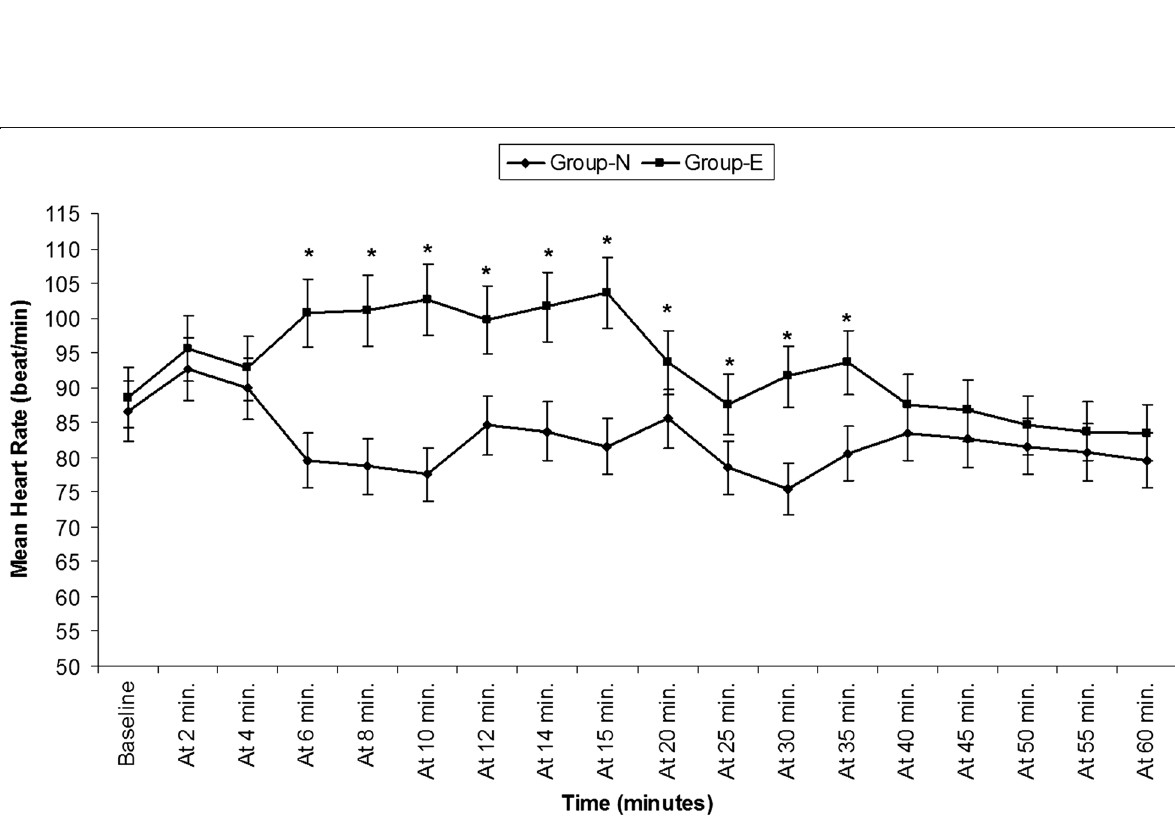
Fig. 2 Comparison between norepinephrine group and ephedrine group according to heart